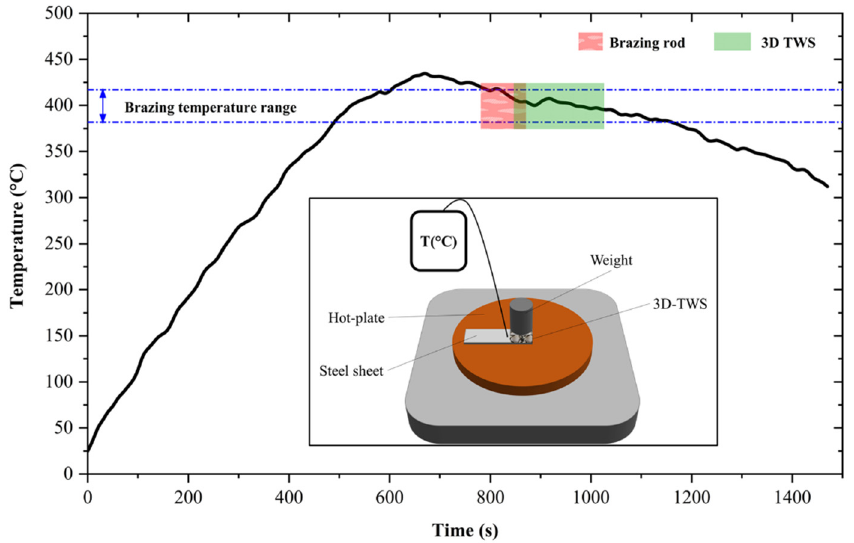
Figure 3. Process flow (temperature vs. time) and the experimental setup (inset) of brazing 3D TWS to galvanized steel sheets using L1 on a hot plate.